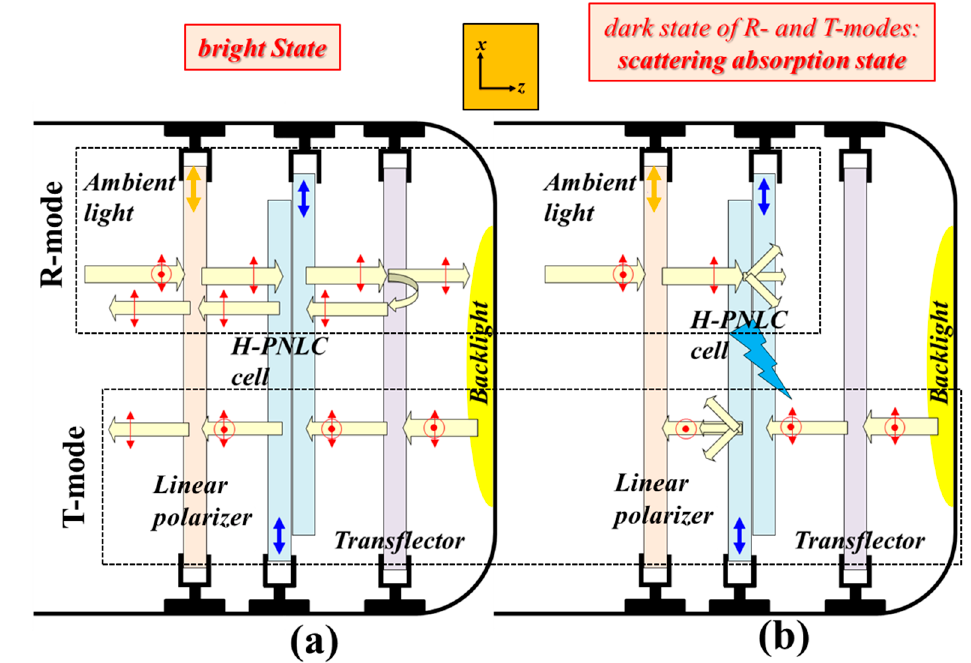
Figure 4. Configurations of a pixel of the ST-TRLCD#2 using an H-PNLC cell in ( a ) voltage-off bright (R- and T-modes) state and ( b ) voltage-on scattering-absorption (R- and T-modes) states. The “light blue thunder” symbol represents that the H-PNLC cell is being applied with a suitable electric field. Blue arrows plotted in H-PNLC cells and orange arrows plotted in linear polarizers represent the rubbing directions of the two substrates of an H-PNLC cell and the transmissive axes of linear polarizers, respectively; red arrows and dots represent the polarization states of LPL.